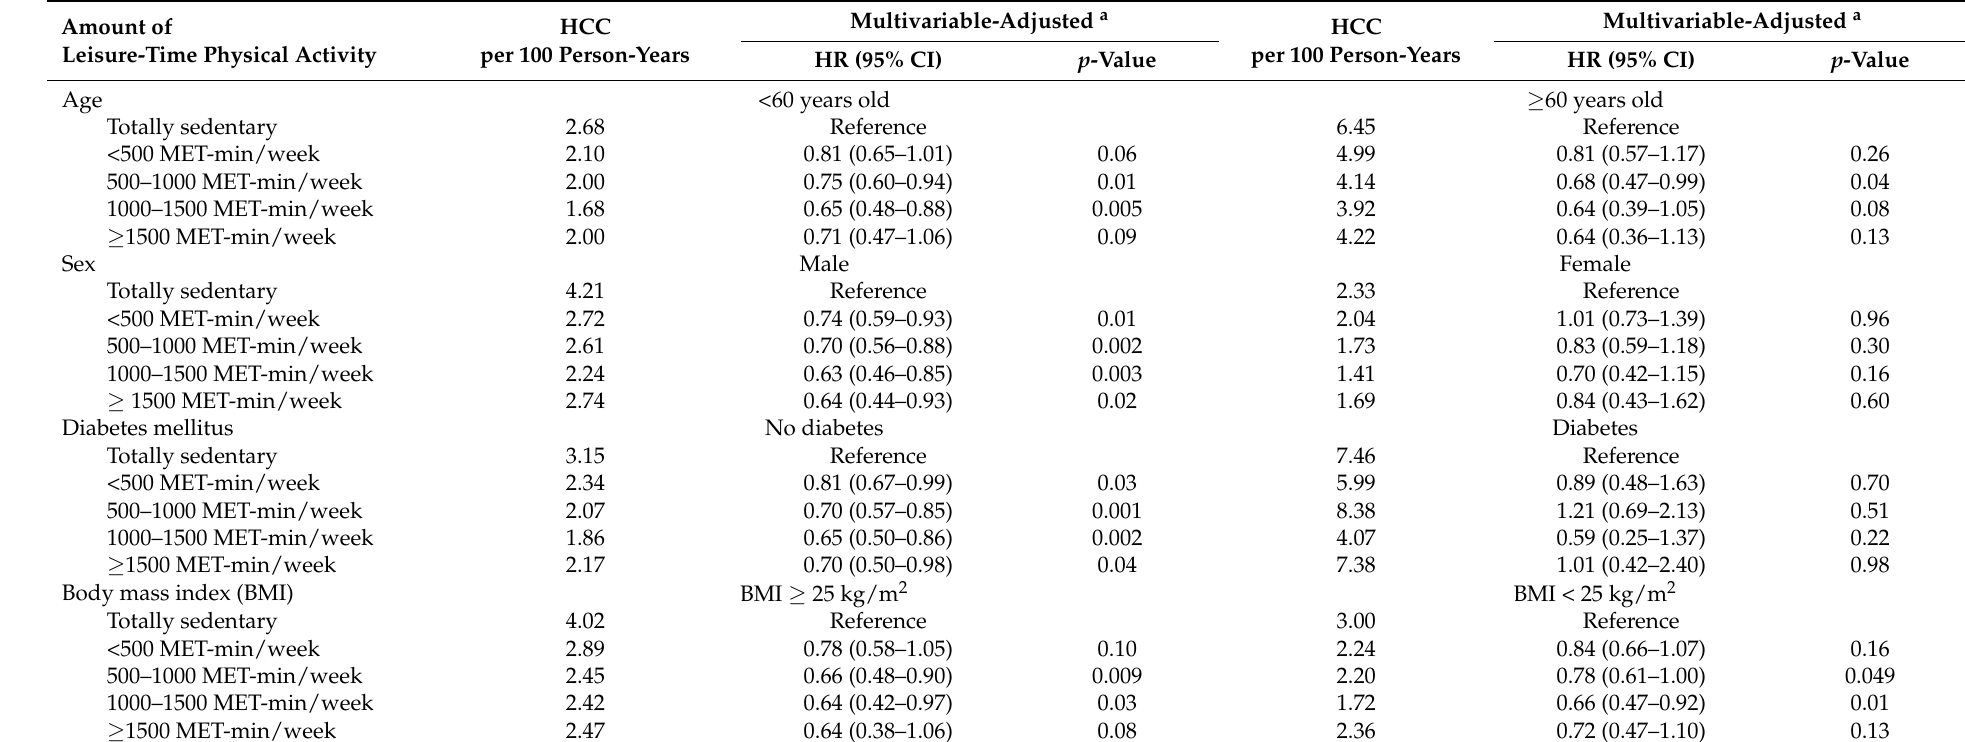
Table 3. Leisure-time physical activity and the risk of HCC development stratified by specific